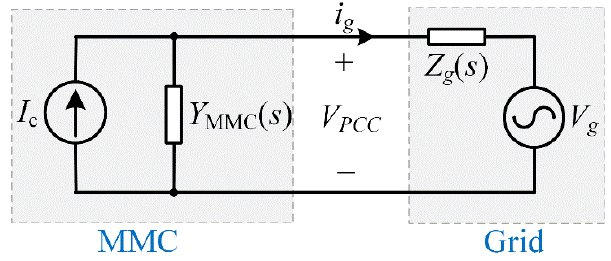
Figure 9. Small-signal representation of the grid-connected MMC system.